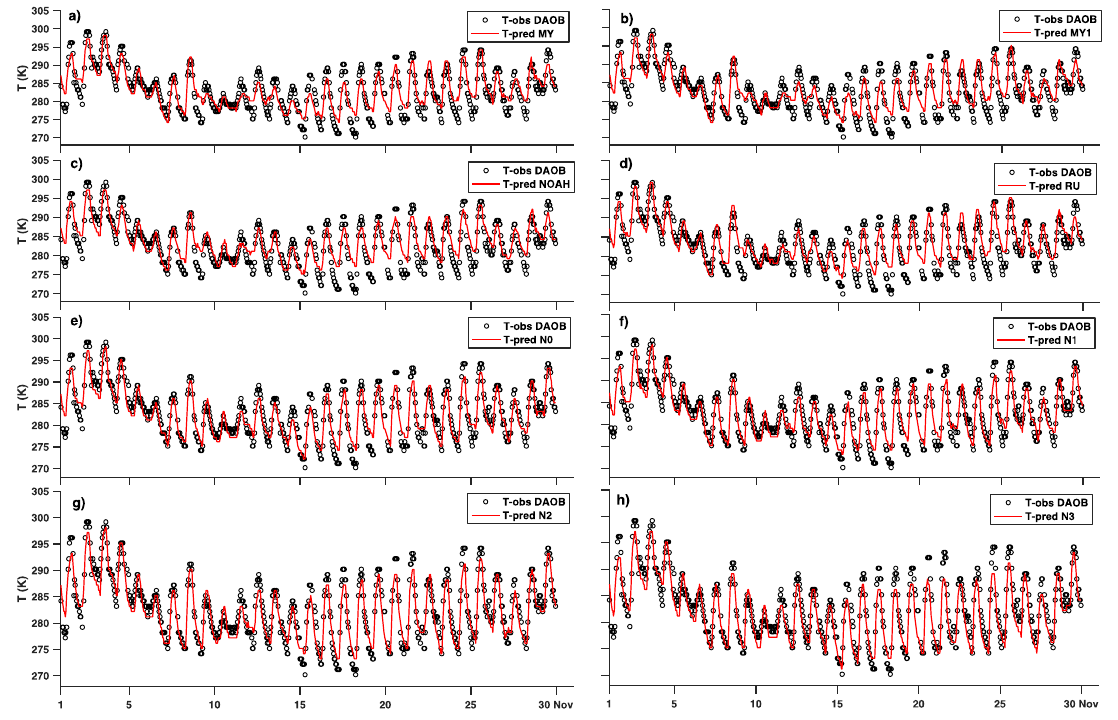
Figure 6. Time series of temperature (T) observed at DAOB meteorological station versus T predicted